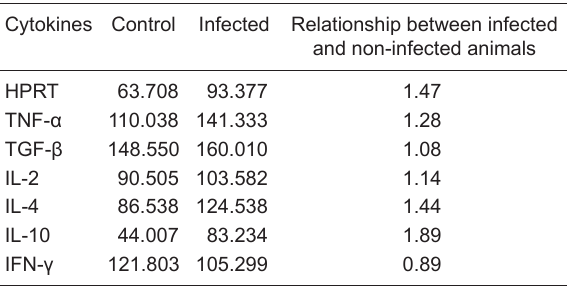
Cytokine mRNA was measured using the Image Lab 1D L340 software. Data are reported as DNA band intensity and are rep- resentative of only 1 animal from each group. The relationship between infected and non-infected animals was measured by the infected band intensity/non-infected band intensity ratio. TNF-α = tumor necrosis factor-α; TGF-β = transforming growth factor-β; IL = interleukin; IFN-γ =